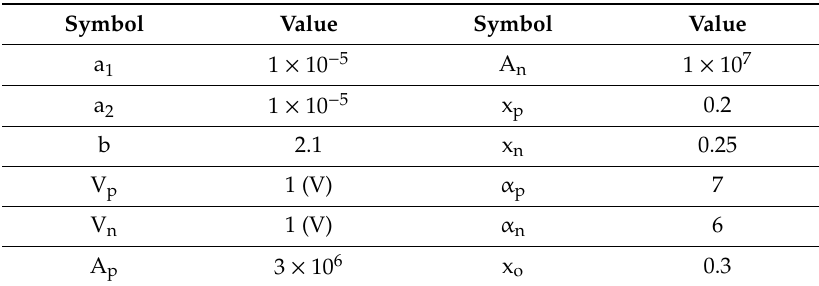
Table 1. Parameters used in the synapse guide